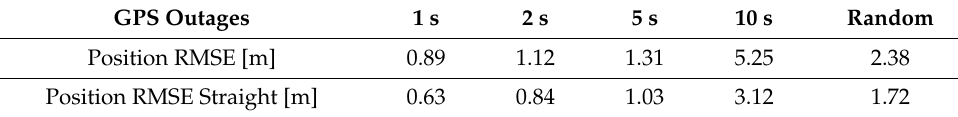
Table 7. RMSE of position EVMs for different GNSS outages.